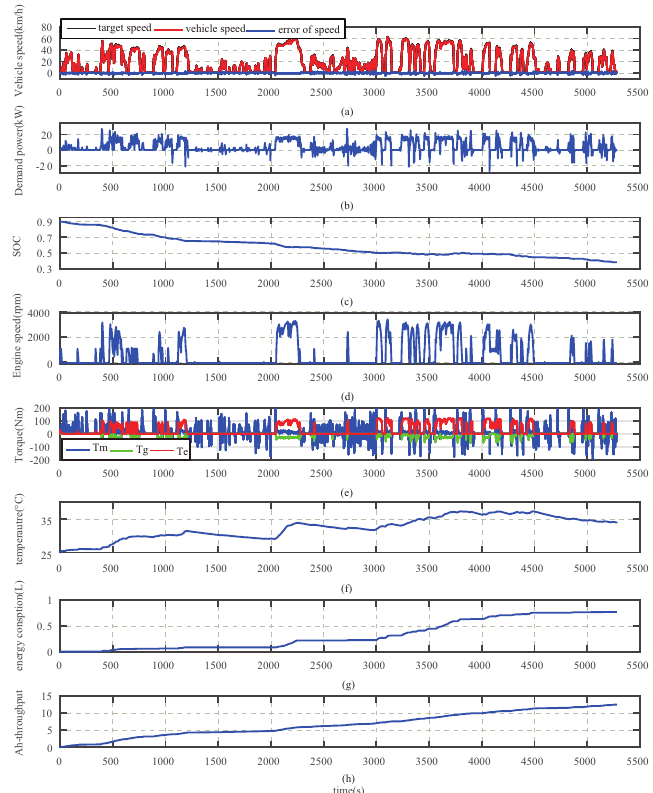
Figure 11. Result with the consideration of both energy consumption and battery life for the second week Monday speed profile. ( a ) Vehicle speed. ( b ) Driver demand power. ( c ) SOC. ( d ) Engine speed. ( e ) Torques of engine, generator and motor. ( f ) Battery temperature. ( g ) Energy consumption. ( h ) Effective